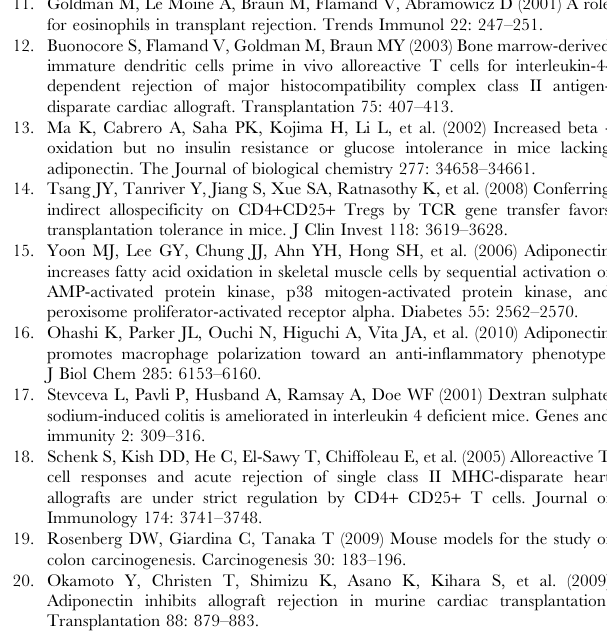
Figure S5 Mixed lymphocytes reaction (MLR). A Bone marrow derived dendritic cells from bm12 as the stimulator cells and T cells isolated from spleen of B6 or Apn 2 / 2 mice as the responder cells. The cells were mixed at different ratios and proliferation was measured with 3H-thymidine incorporation. B and C The maturation of dendritic cells from bm12 or B/c. Bone marrow cells were isolated and cultured for 7 days in present of IL- 4 and GM-CSF, the cells was added LPS (100 m g/ml) for 1 more day to induce the maturation. CD80, CD86 and MHC class II were used as maturation markers. (TIF) Figure S6 Expression of AdipoR1 and AdipoR2 on T cells isolated from spleen of B6 and Apn 2 / 2 mice. The T cells were isolated with Dynal H CD4 Negative Isolation Kit and total RNA was extracted. The mRNA expression levels were determined by quantitative Q-PCR. (TIF) Table S1 The primers used in Quantitative real-time PCR (Q-PCR). The primers were synthesized by Invitrogen Hong Kong Ltd. (DOC) Table S2 Serum levels of IFN- c and IL-2 at 7 days post- operatively in mice following skin grafting. n= 6 in each group ( { p , 0.01 compared to B6 to B6; {{ p , 0.001 compared to { p , 0.05 compared to Apn 2 / 2 to Apn 2 / 2